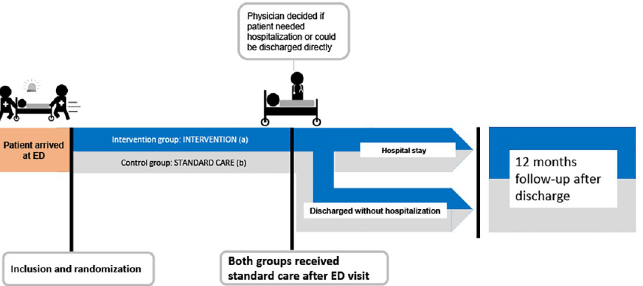
Fig 2. Study design. During emergency department (ED) stay the Intervention group (a) received standard care and pharmacist conducted systematic medication review (identifying drug-related problem), including medication reconciliation (obtaining patients’ actual drug lists). Findings from medication reconciliation and medication review were discussed with ED physician and documented in the electronical patient record. The control group (b) received standard care (by physicians and